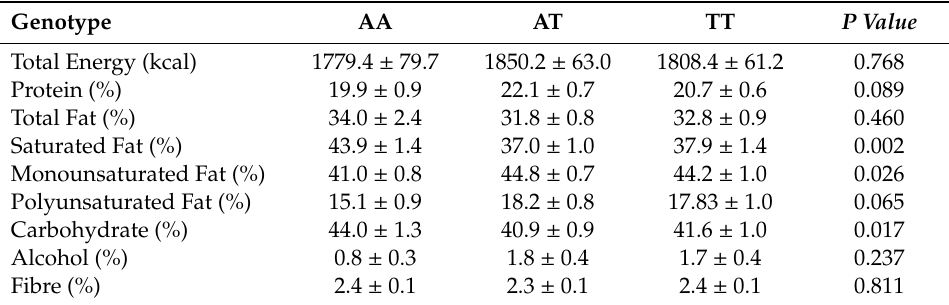
Table 2. Nutritional intake analysis of the studied cohort based on their FTO rs9939609 genotype. Values are expressed as mean ± SEM. Significant interactions (bolded, p < 0.05) were observed between FTO genotypes.